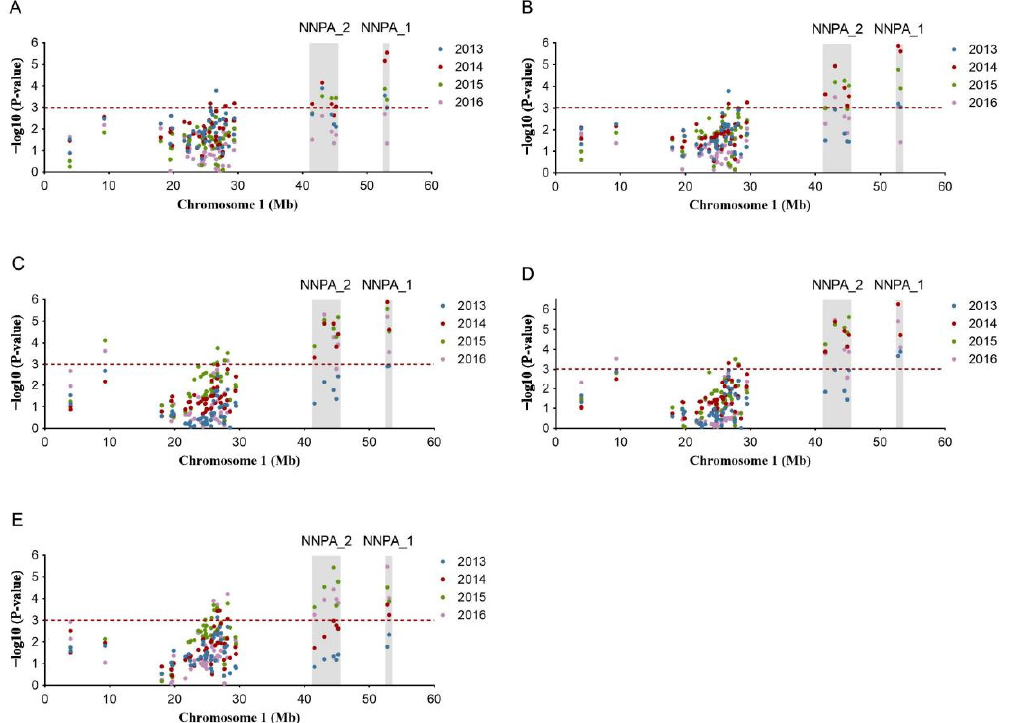
Figure 3. Manhattan plots of SSR and InDel markers associated with PA-related traits within the candidate regions on Chromosome 1 in lotus ( Nelumbo Adans.). ( A ) Petiole height, ( B ) peduncle height, ( C ) leaf length, ( D ) leaf width, and ( E ) flower diameter. The blue, red, green, and purple dots represent the results of association analysis in 2013, 2014, 2015, and 2016, respectively. The horizontal red dashed line indicates the threshold with significant differences at − log10 ( p value) = 3. The shadow lines represent the fine-mapped interval NNPA_1 and NNPA_2.